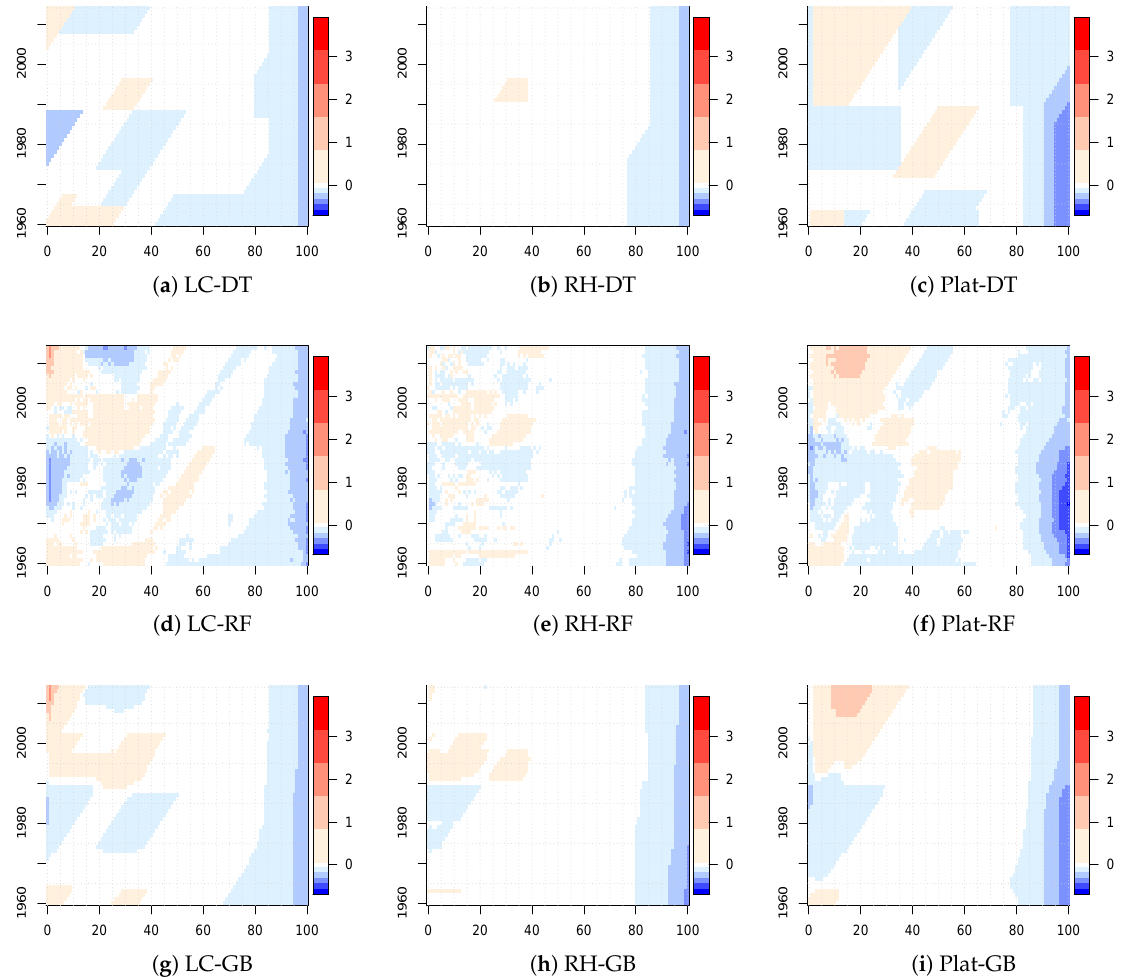
Figure 5. Values of ∆ m mdl,ML x . Italian male population. Ages 0–100 and years